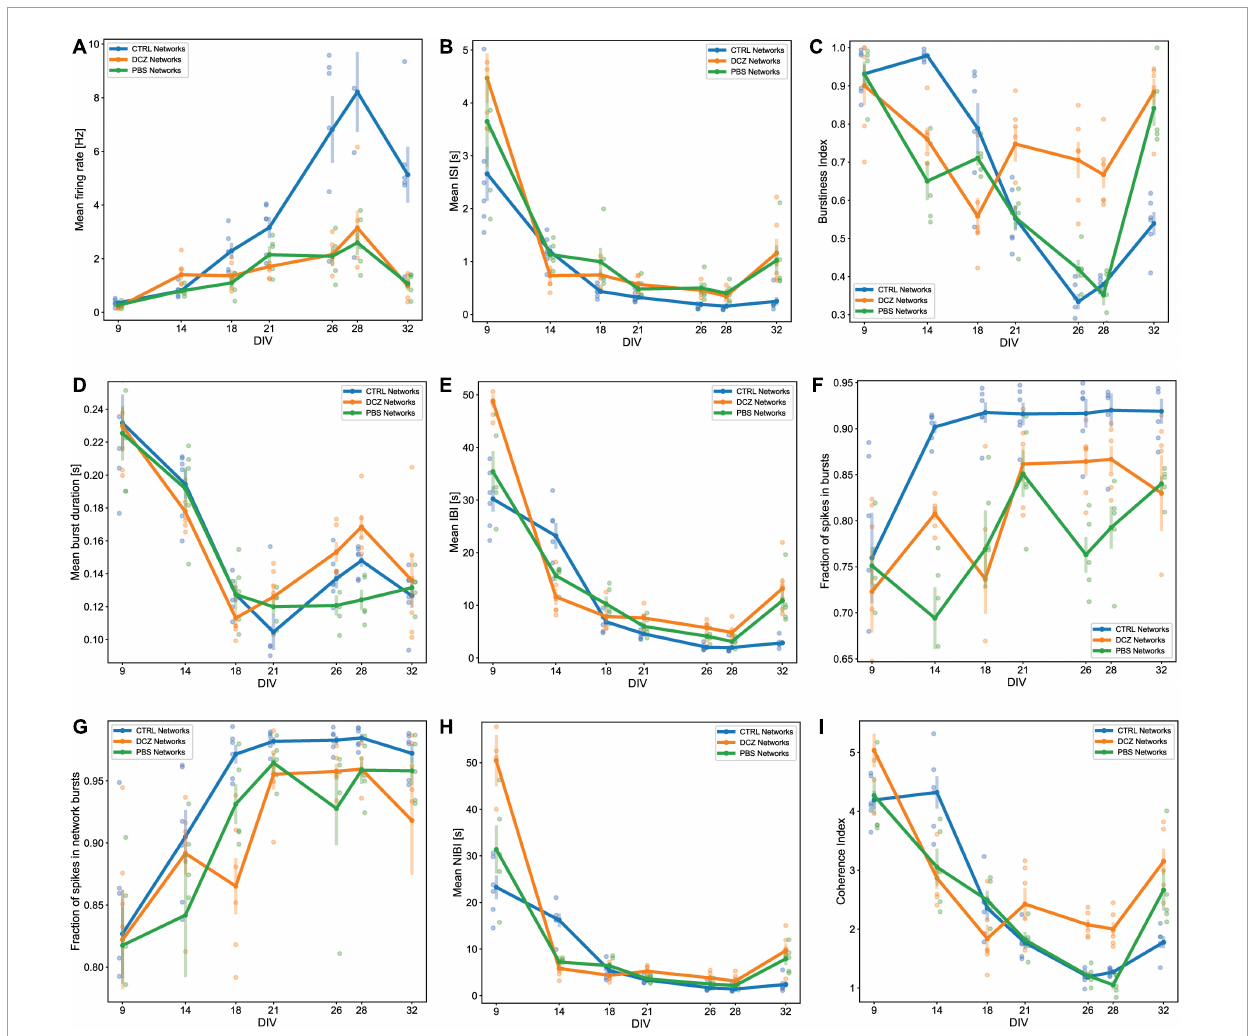
FIGURE5 Activity and burst composition at baseline across 5 weeks of recording. Each plot presents the mean activity for all the networks in each condition [DCZ treated ( n = 6), PBS vehicle ( n = 5) or CTRL ( n = 6)]. Network behavior for each condition is described in terms of mean firing rate (A) , mean inter spike intervals (ISI) (B) , burstiness index (C) , mean burst duration (D) , mean inter burst intervals (IBI) (E) , fraction of spikes in bursts (F) , fraction of spikes in network bursts (G) , mean network IBI (H) , and coherence index (I) . The solid lines with solid circles plot the mean values for all networks in one group, the shaded bars show the standard error of the mean, and the shaded circles show the individual data points (the mean activity obtained from each network in each